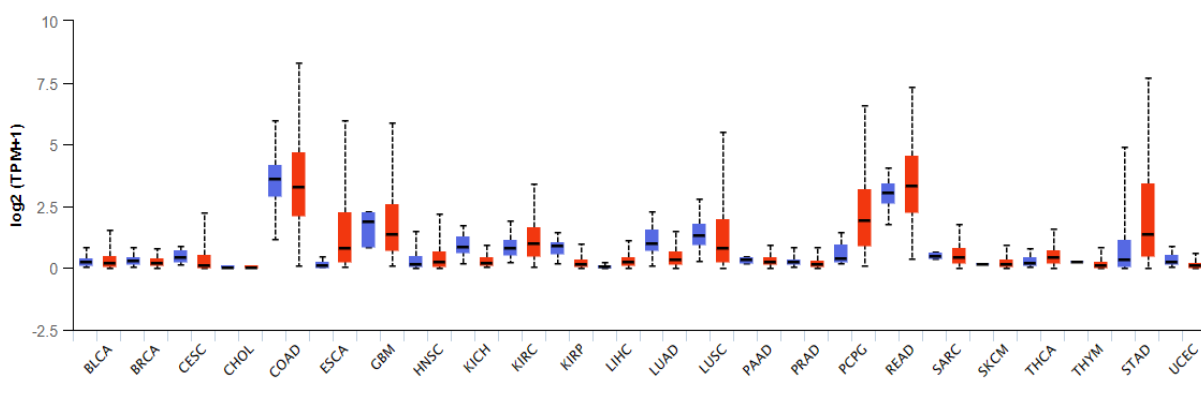
Figure 2: Figure 1. iNOS/NOS2 mRNA relative expression levels in multiple